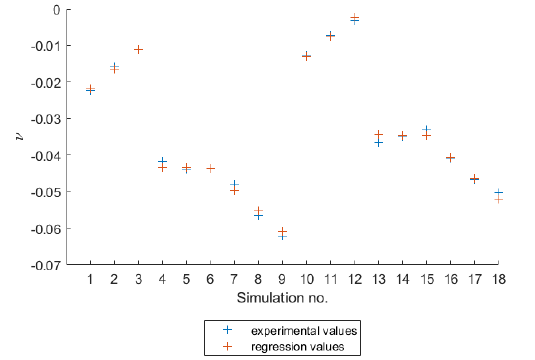
Figure 9. ν : Comparison experimental values and regres– sion values